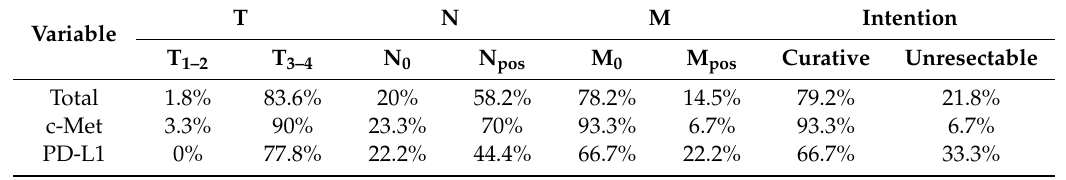
Table 2. TNM stages and treatment intentions of analyzed PDAC-patients.